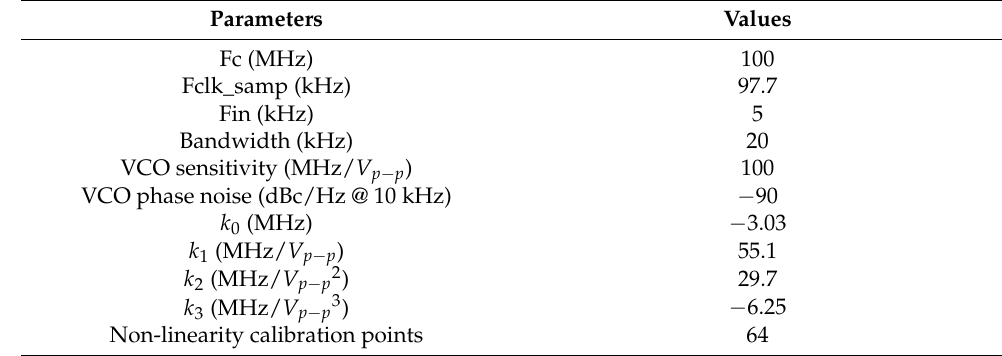
Table 1. List of parameters used for the behavioral simulation.